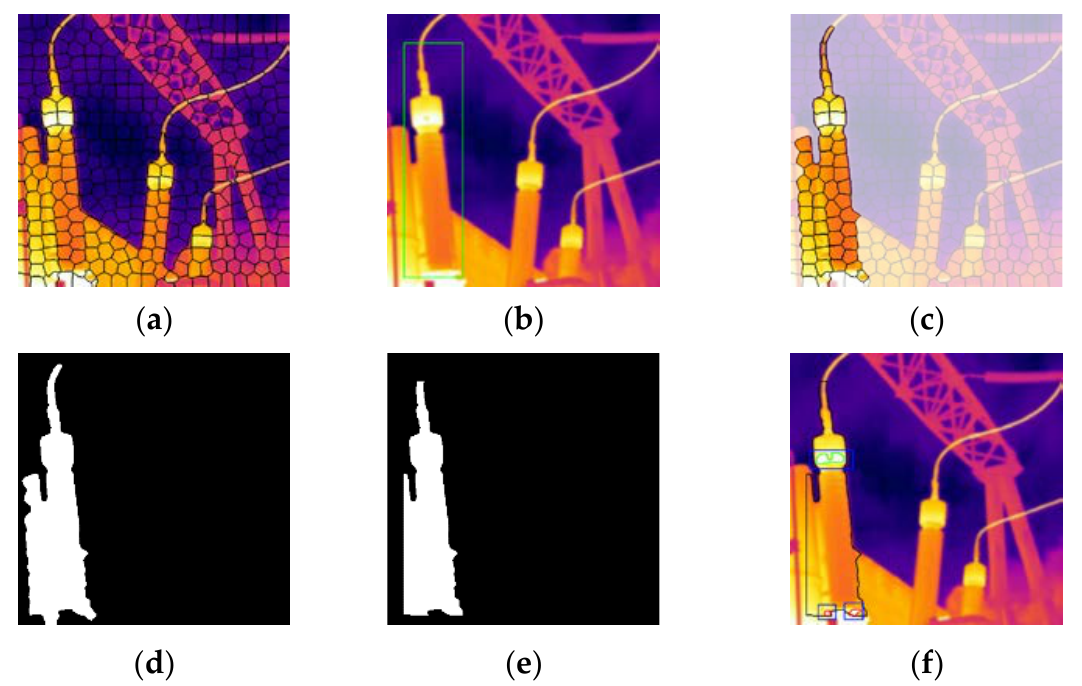
Figure 7. The results of each step in the process of diagnosis by LR image ( a ) Super pixel segmentation ( b ) Image recognition ( c ) Super pixel binning ( d ) Image segmentation ( e ) Area to be inspected ( f ) Diagnosis result.